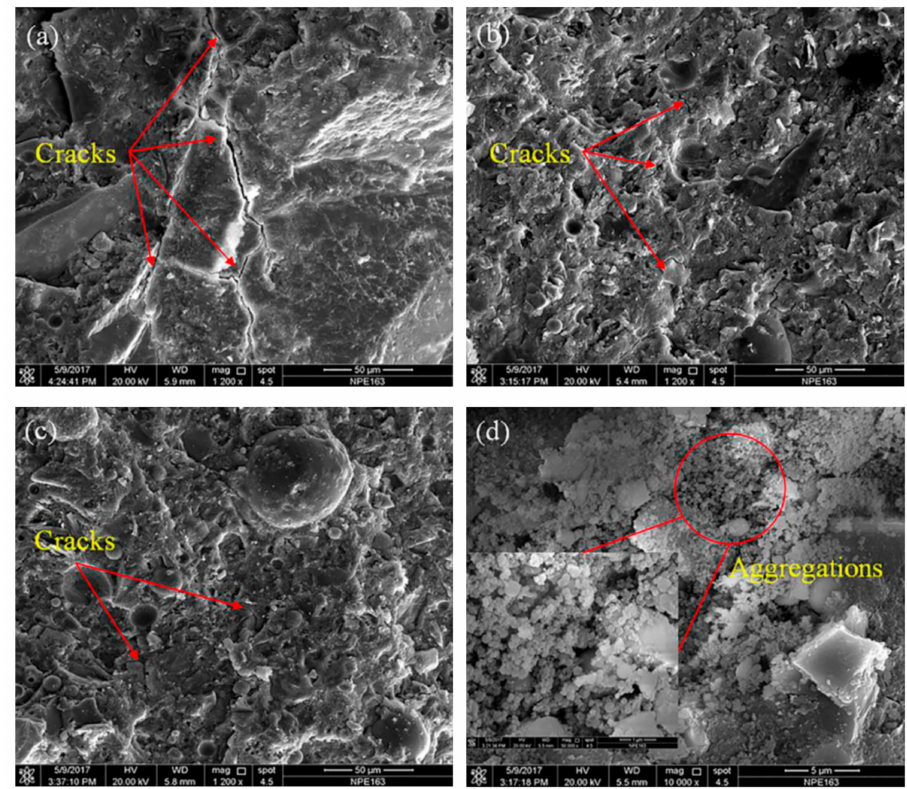
Figure 10. SEM image of the fracture surfaces considering: ( a ) control cementitious composites (1200 × ); ( b ) nano-TiO 2 (50 nm size) modified cementitious composites (1200 × ); ( c ) nano-TiO 2 (500 nm size) modified cementitious composites (1200 × ); ( d ) aggregations of nano-TiO 2 (50 nm size) in cementitious composites (1200 × ). Reprinted with permission from [96]. Copyright © 2019, Elsevier